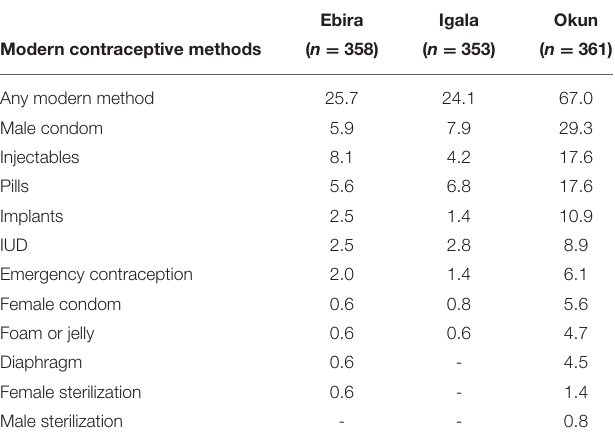
TABLE 2 | Percentage distribution of respondents currently using modern contraceptive.